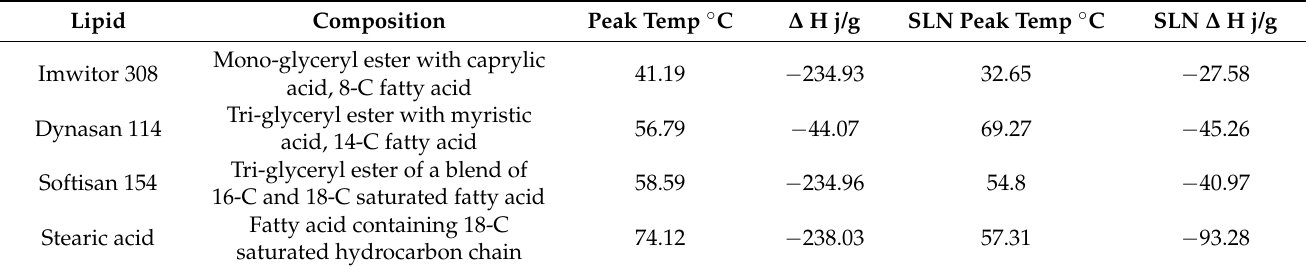
Table 3. DSC peak temperatures and enthalpies ( ∆ H j/g) for some pure lipids and their analogues inside SLN